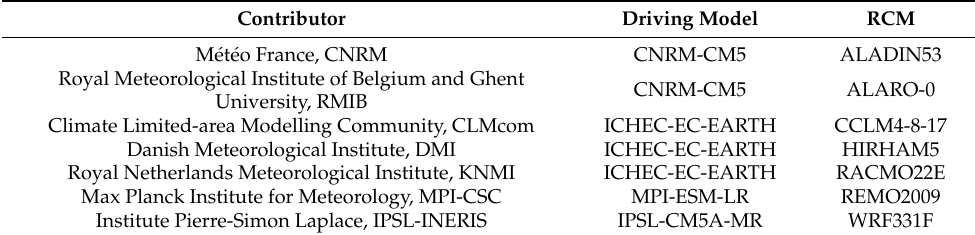
Table 1. Acronyms of the Regional Climate Models (RCM) and corresponding driving models.